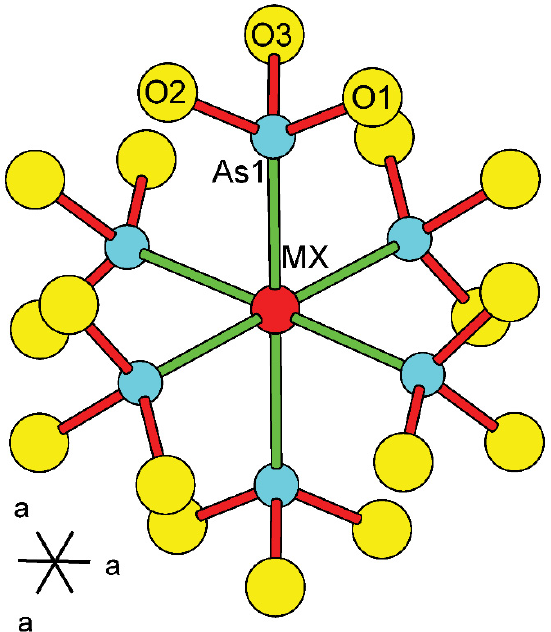
Figure 3. Coordination of channel MX site in magnussonite.